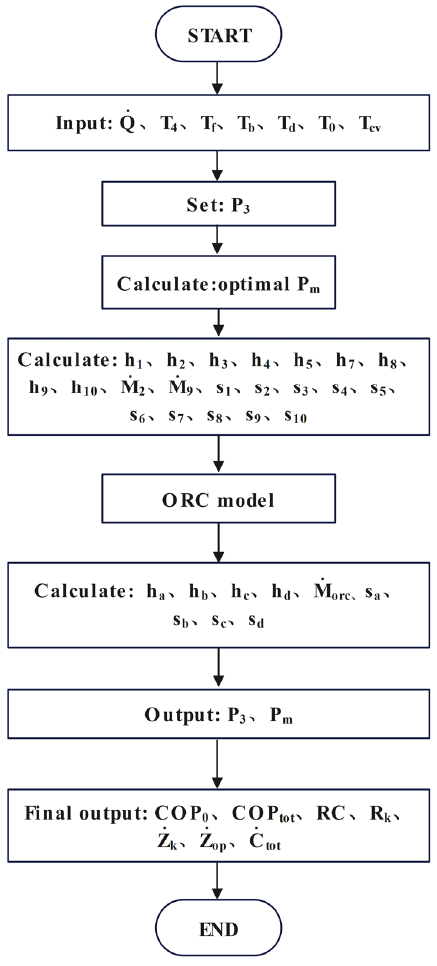
Figure 3. Calculation flow diagram of the coupled system performance analysis.